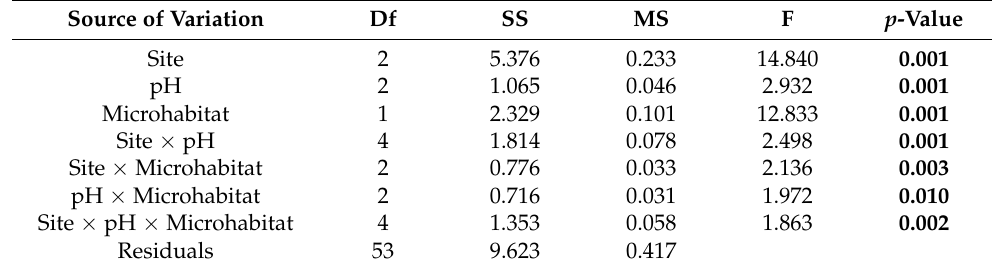
Table 4. Results of permutational multivariate analysis of variance (PERMANOVA) on mollusc assemblages found on P. oceanica meadows. Significant values are highlighted in bold.